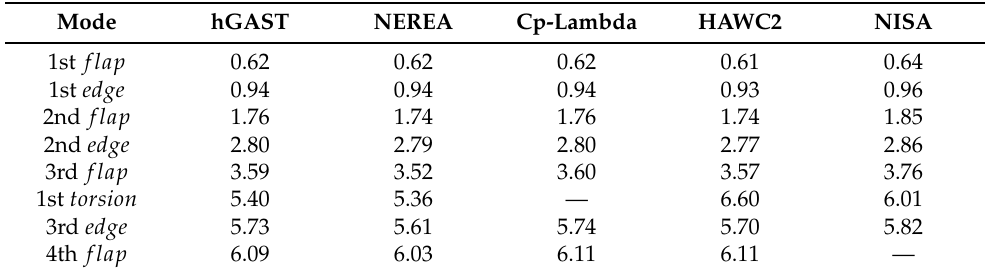
Table 9. DTU 10MW blades natural frequencies. Comparison between different structural models used in WP2 of the INNWIND.EU project.